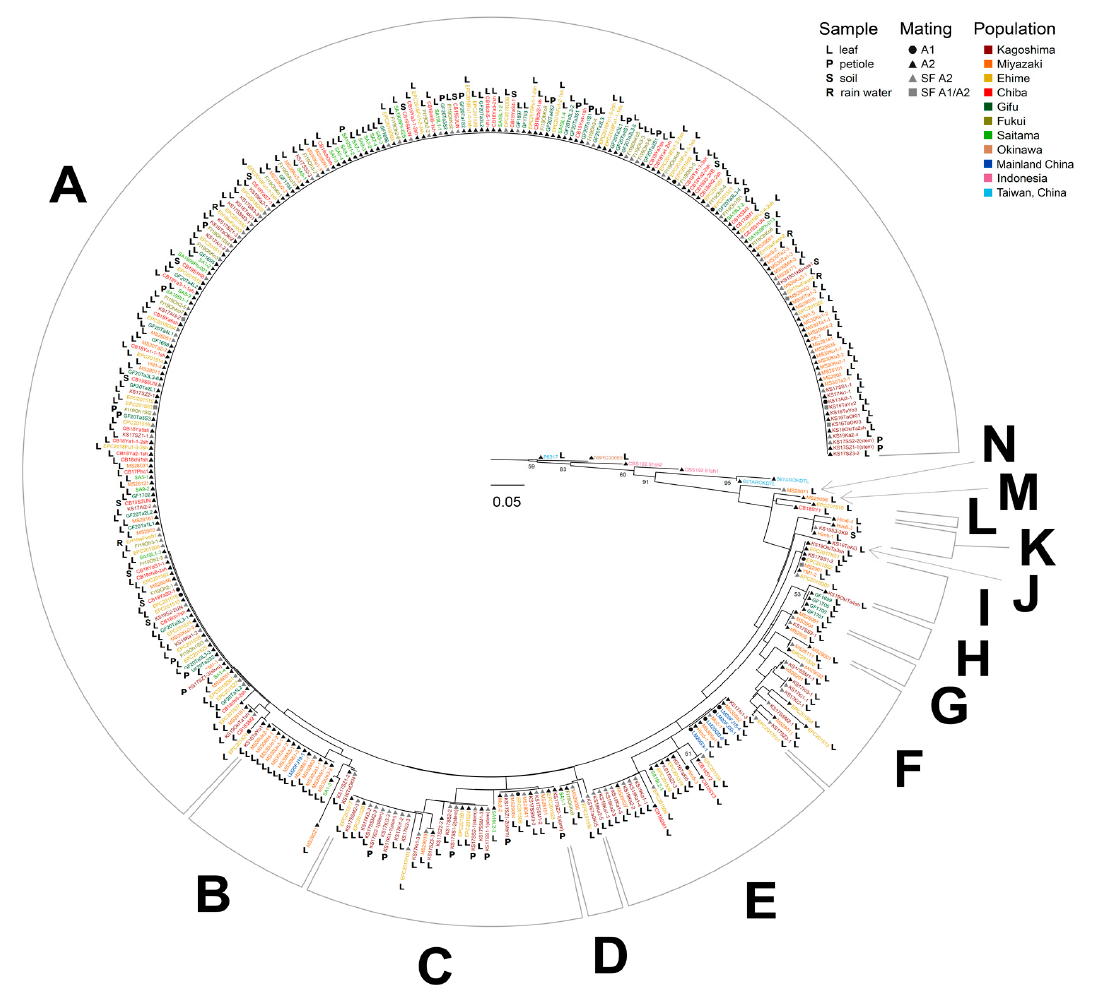
Figure 2. Multilocus microsatellite phylogenetic tree of 358 isolates of Phytophthora colocasiae . Numbers above branches are bootstrap values (>50). Genotype groups are labeled with A to N. SF: self-fertilization.